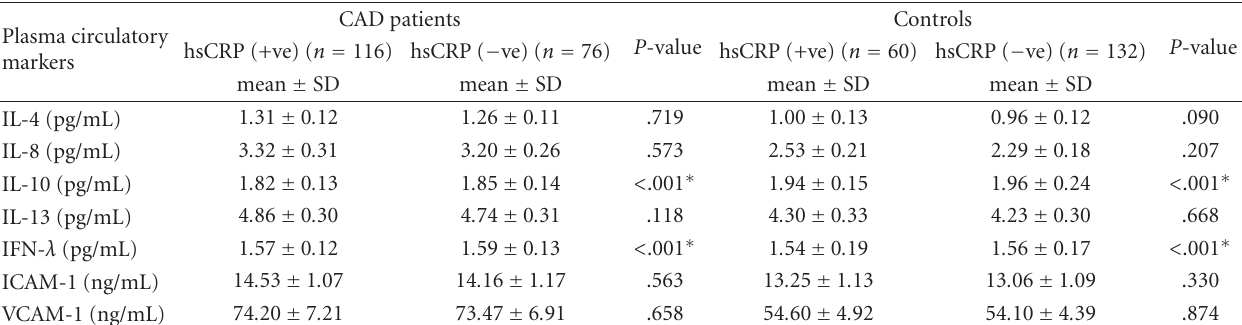
Table 4: Evaluation of plasma circulatory markers in high-sensitive C-reactive protein positive coronary artery disease patients and controls. Plasma circulatory